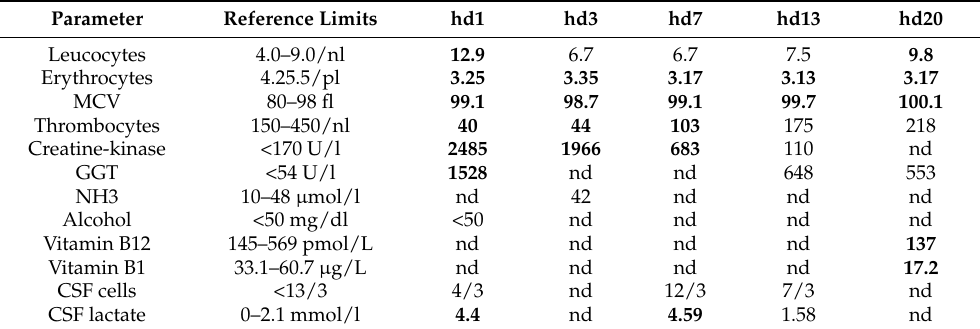
Table 1. Relevant blood tests obtained during